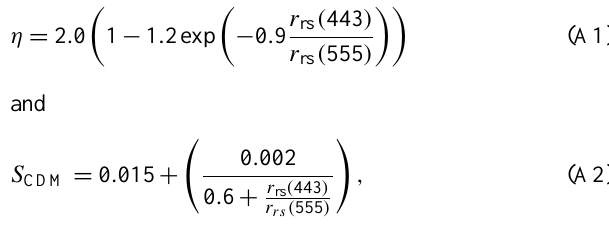
Table A2. Regression analyses between a CDOM (443) and R rs (λ) band ratio using SBI spr and SBI sum